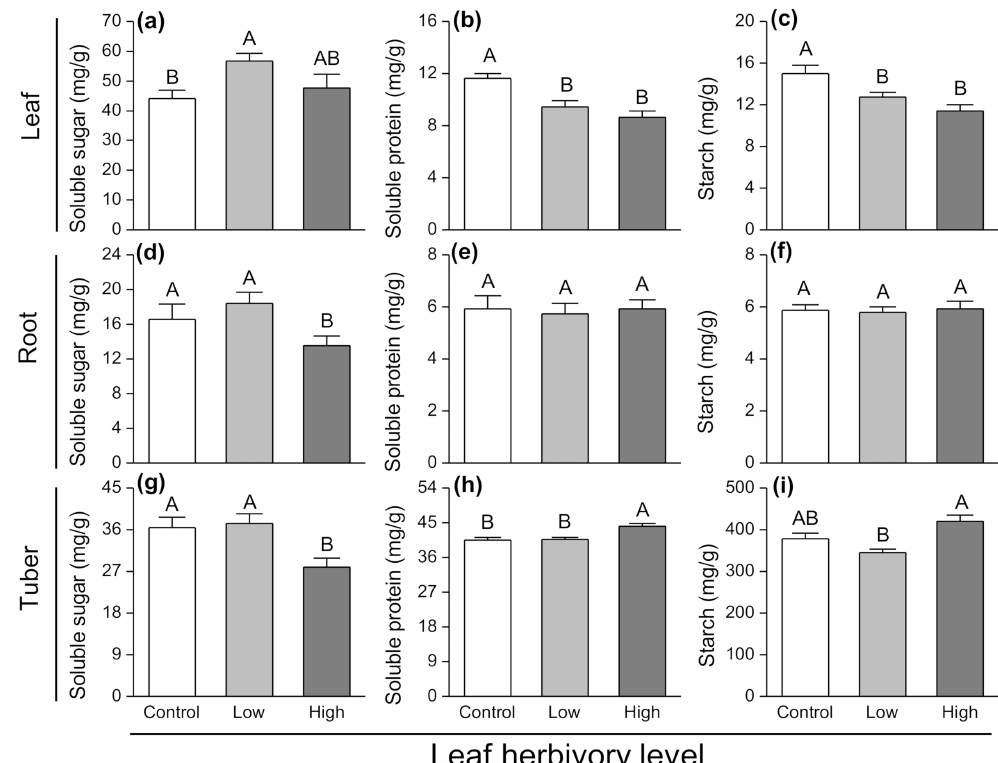
Figure 3. Changes in ( a – c ) soluble sugar, ( d – f ) soluble protein and ( g – i ) starch contents in di ff erent plant components (leaf, root and tuber) of potato plants exposed to di ff erent herbivory levels of Phthorimaea operculella . Data are means ± SE. Di ff erent letters indicate significant di ff erences among treatments ( p < 0.05) based on post hoc Tukey’s HSD